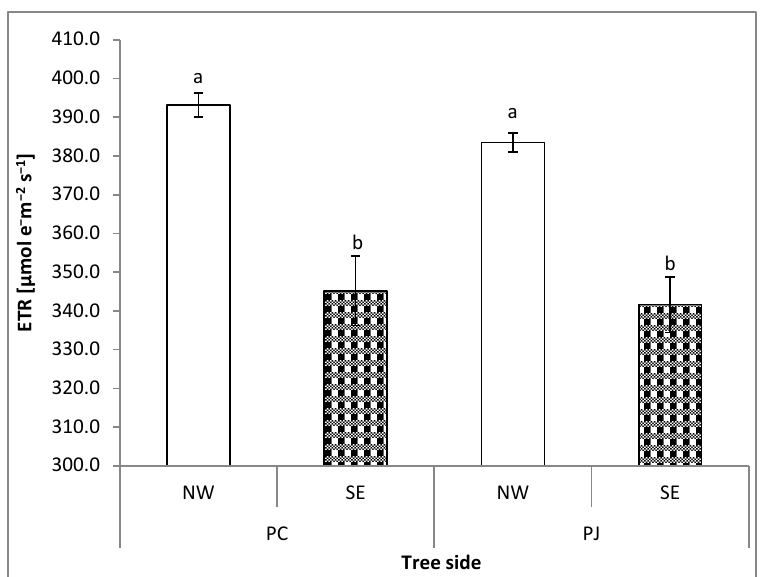
Figure 3. Changes in electron transport rate (ETR) [μmol e − m − 2 s − 1 ] in Prosopis juliflora and Prosopis cineraria leaves from east and west canopy directions. Each bar in a graph represents the mean (±S.E.) of three replicates. Means with the same letters within a species indicate insignificant difference between the two canopy positions at p > 0.05 according to Duncan Multiple range test.